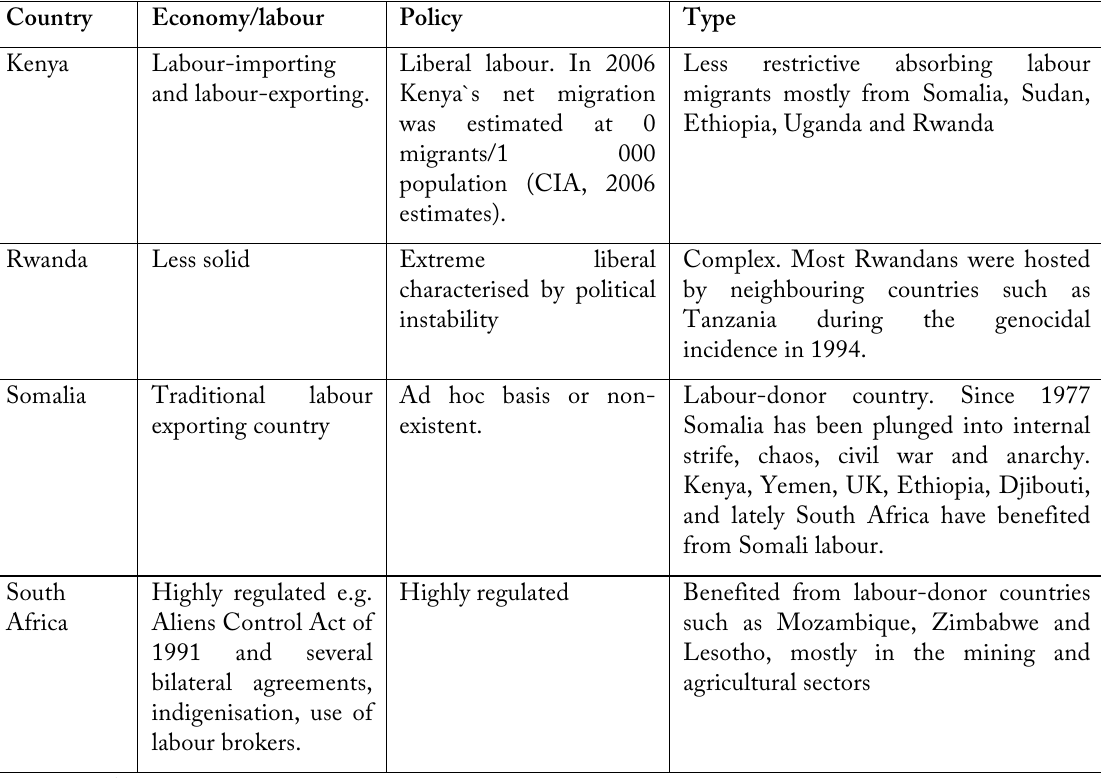
Table 1: Management of transnational migration by selected Southern African countries Country Economy/labour Policy Type Labour-importing and